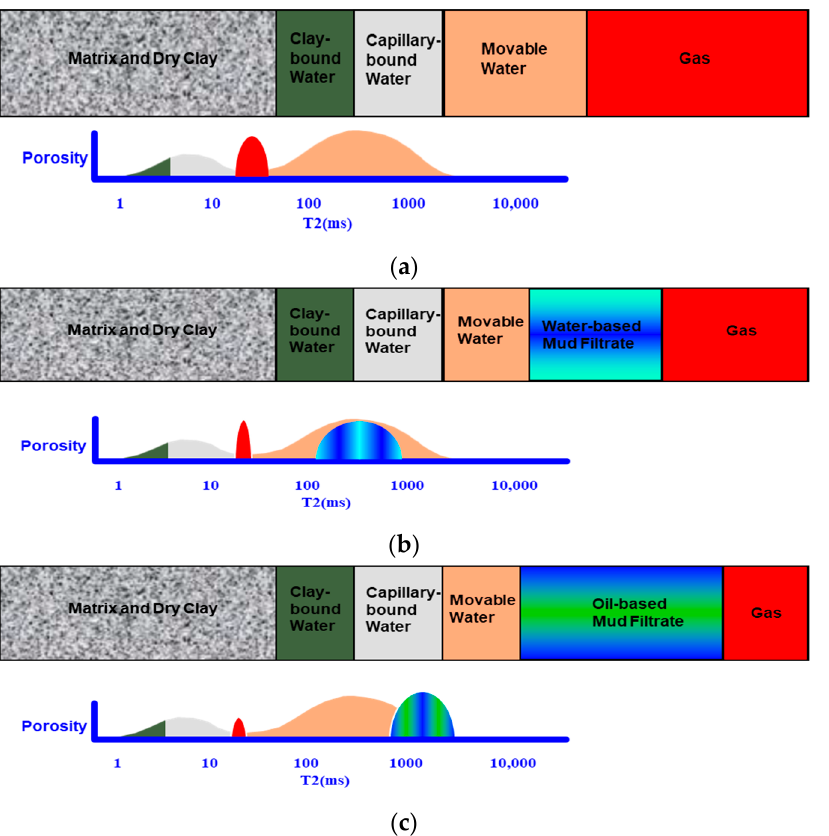
Figure 2. Gas reservoir volume model and theoretical NMR T 2 spectrum diagram. ( a ) Volume model of gas-bearing reservoirs in undisturbed formations and theoretical distribution of the nuclear magnetic T 2 spectrum. ( b ) Volume model of gas-bearing reservoirs in water-based mud wells and theoretical distribution of the nuclear magnetic T 2 spectrum. ( c ) Volume model of gas-bearing reservoirs in oil-based mud wells and theoretical distribution of the nuclear magnetic T 2 spectrum.